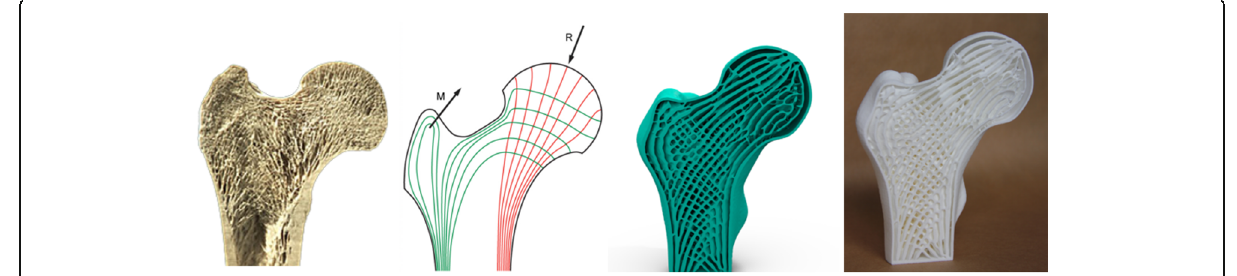
Fig. 18 Infill design on account of the principal stress directions and the 3D printed bone model [40]